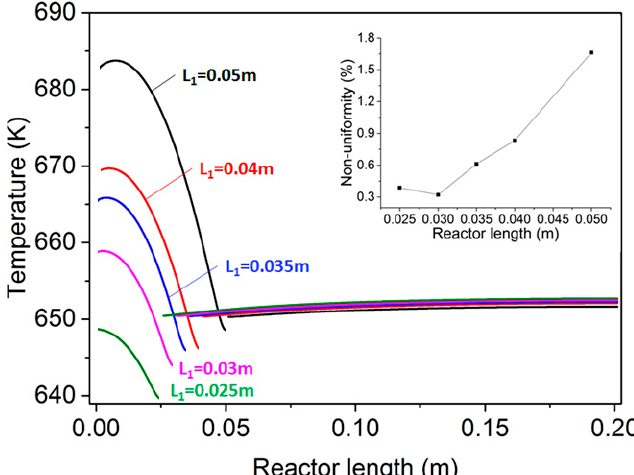
Figure 6. Temperature profiles in the catalyst, as a function of the position of the additional coolant inlet (L 1 ). First section: counter-current flow. Second section: co-current flow. The insert: tempera- ture non-uniformity parameter, as a function of the coolant inlet position. Coolant temperature: 498 K. Coolant velocity in each section: 9.0 × 10 − 2 m s − 1 . Plate thickness, a = 1.5 mm.